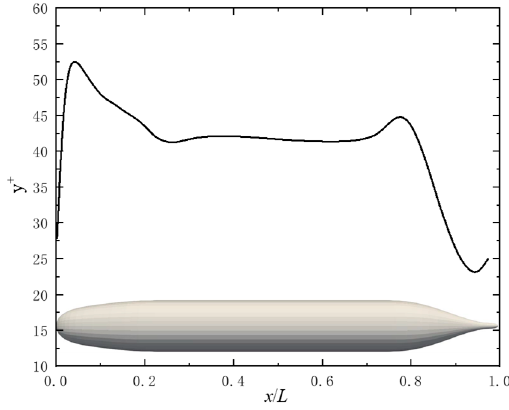
Figure 3. y + distribution on the surface of SUBOFF.